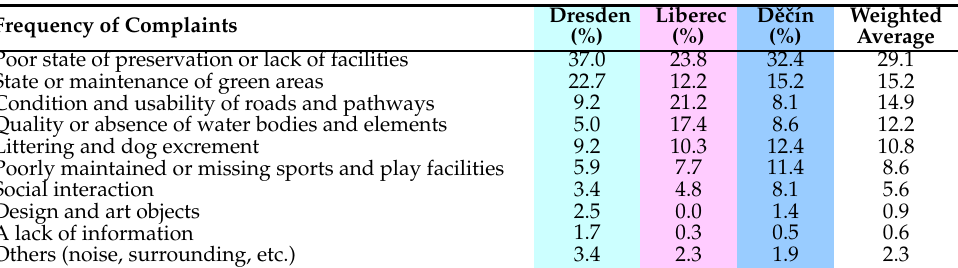
Table 5. Complaints about disturbing